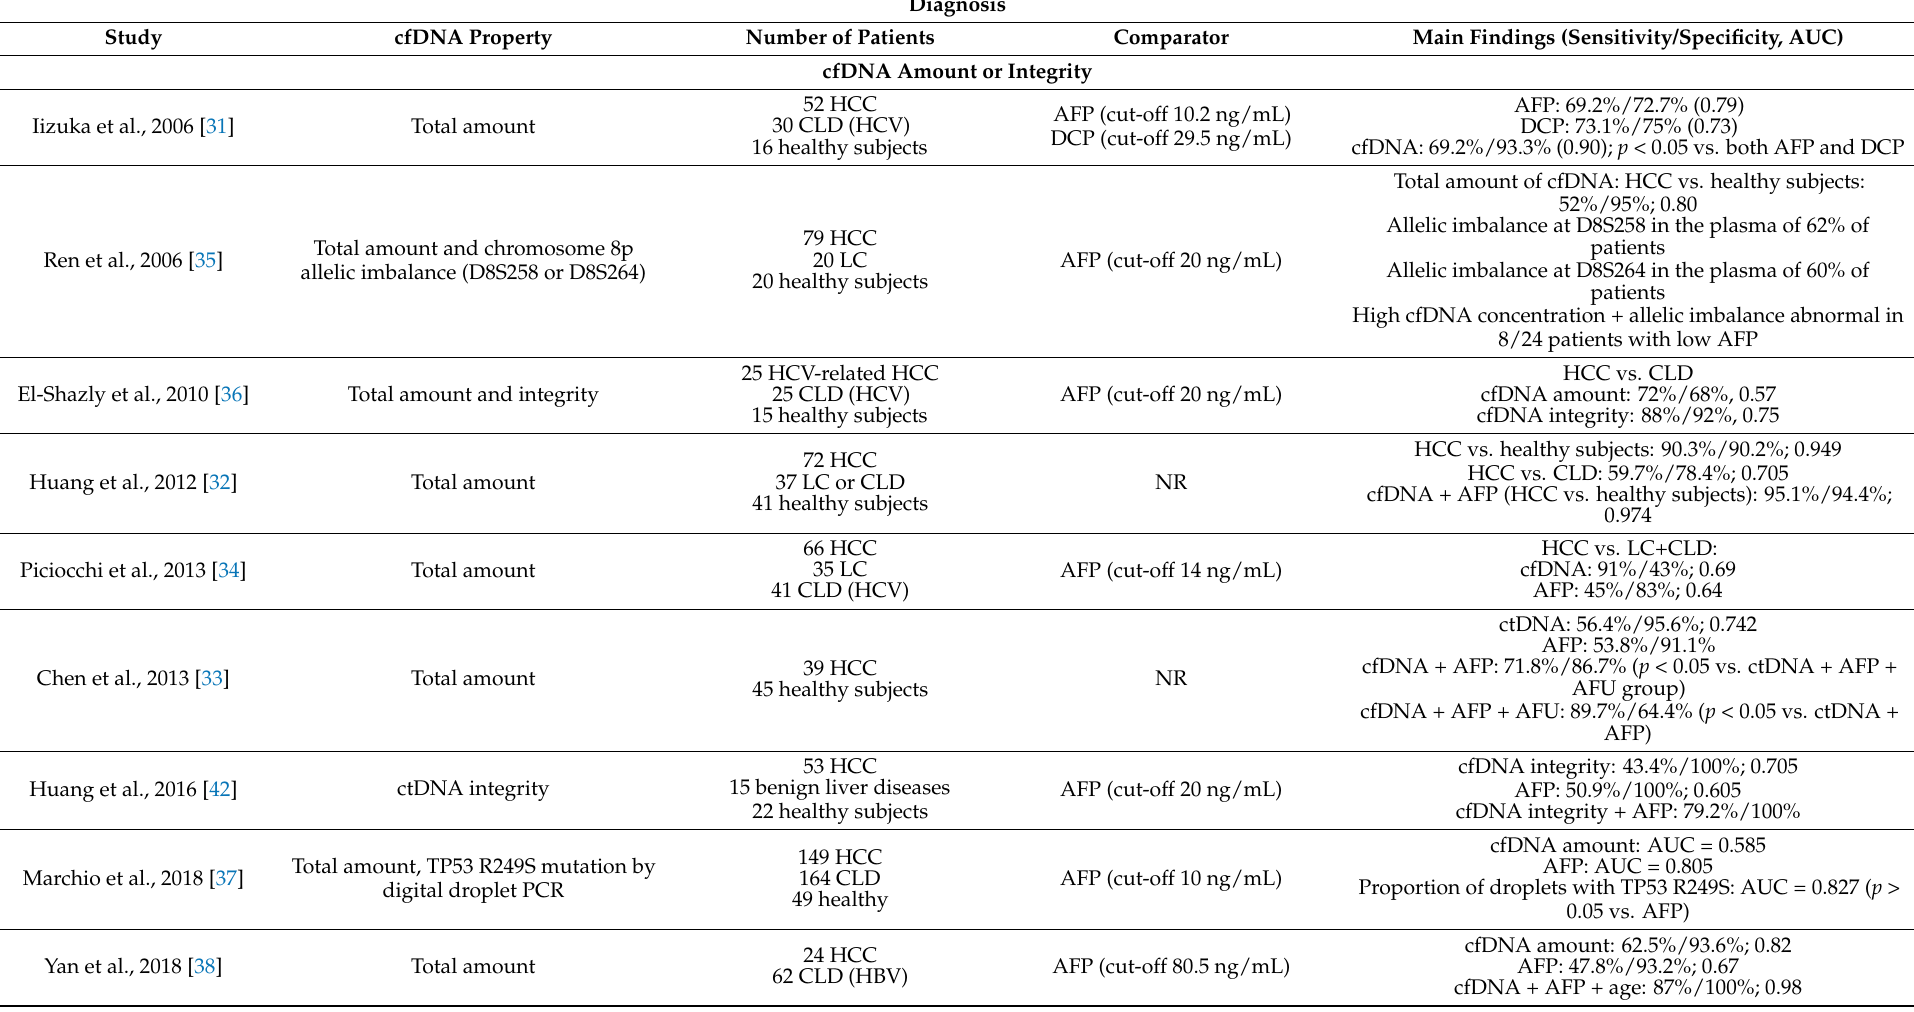
Table 1. Studies on cell-free DNA (cfDNA) as biomarker in HCC